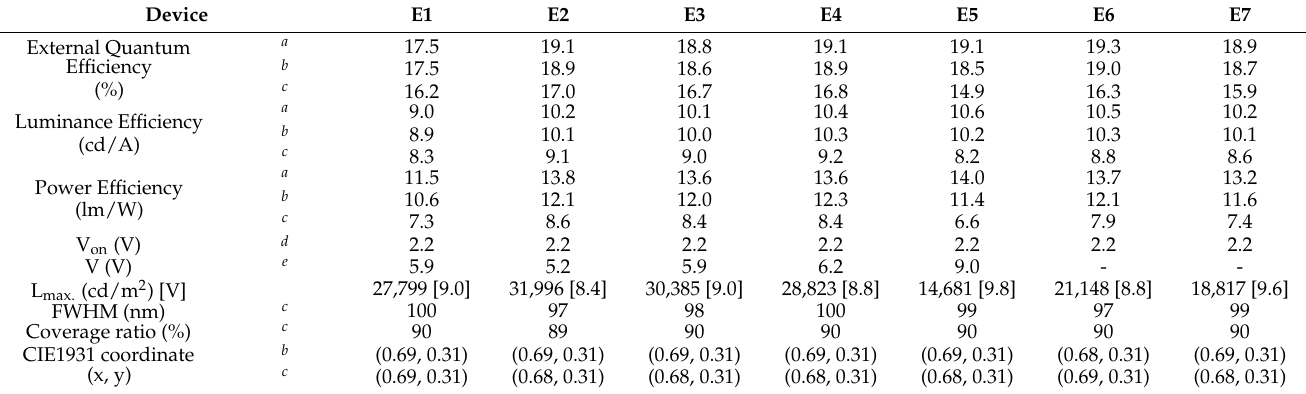
Table 3. EL characteristics of the tested deep-red PhOLEDs with different HIL